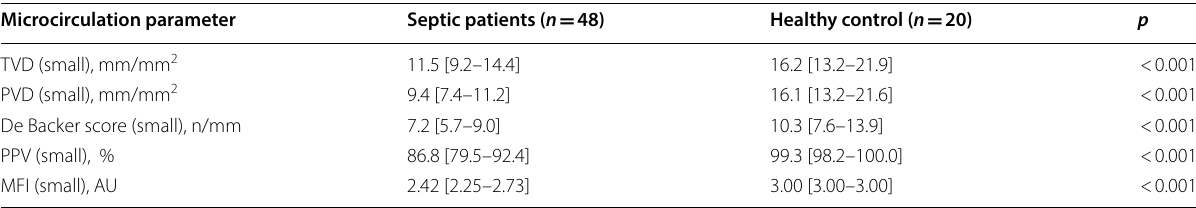
Data are presented as median [IQR] TVD total vascular density, PVD perfused vascular density, PPV Proportion of perfused vessels, MFI microcirculatory flow index